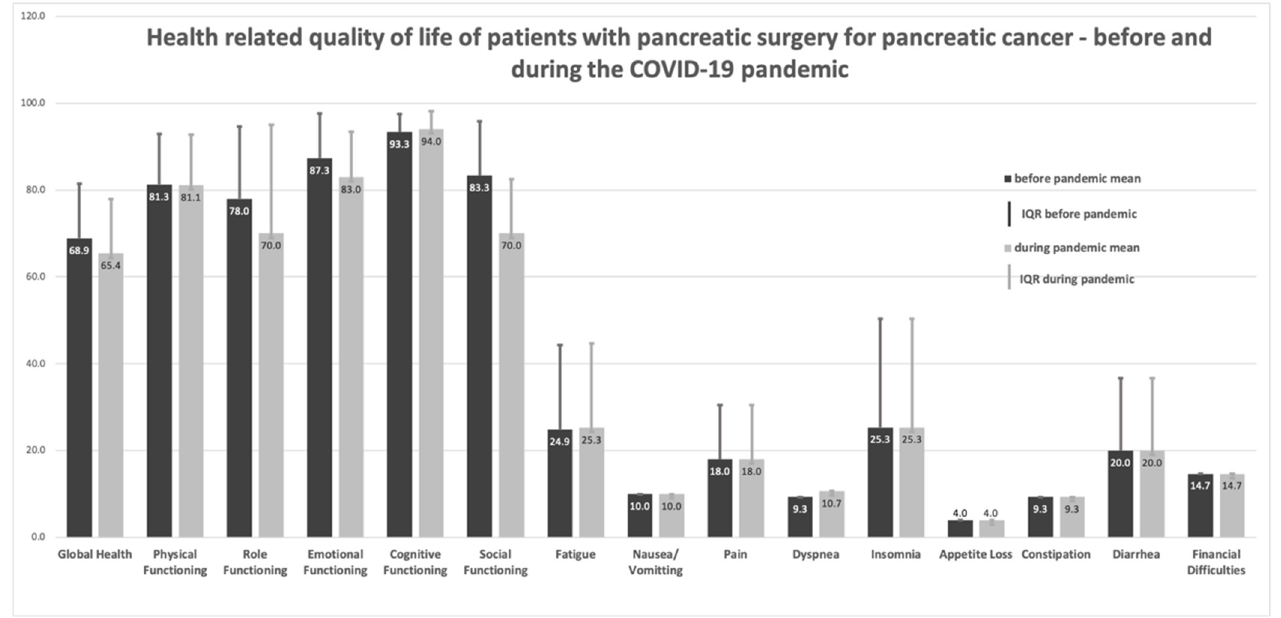
Figure 1. Health-related quality of life of patients with pancreatic surgery for pancreatic cancer— before and during the COVID-19 pandemic. Measurement: EORTC QLQ C-30. Small deteriorations: emotional functioning, role functioning. Medium deterioration: social functioning. All other differ- ences: trivial (according to Cocks 2012).